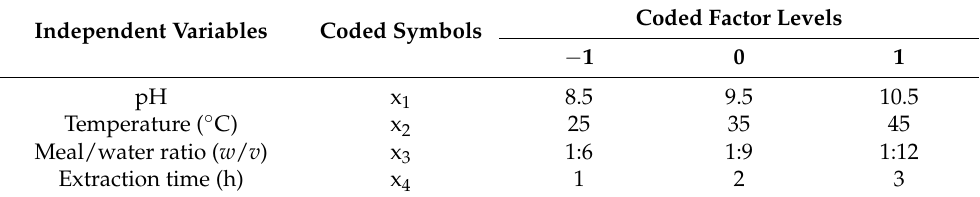
Table 1. Independent variables and their levels in the response surface